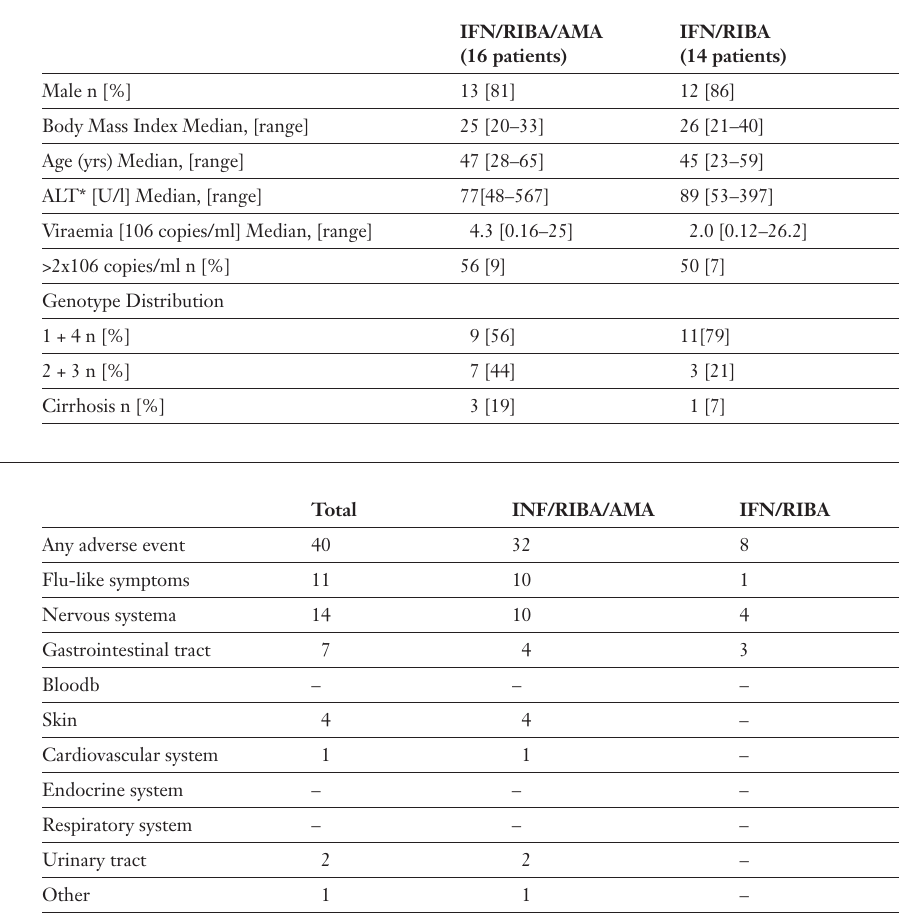
Table 1 Baseline characteristics.